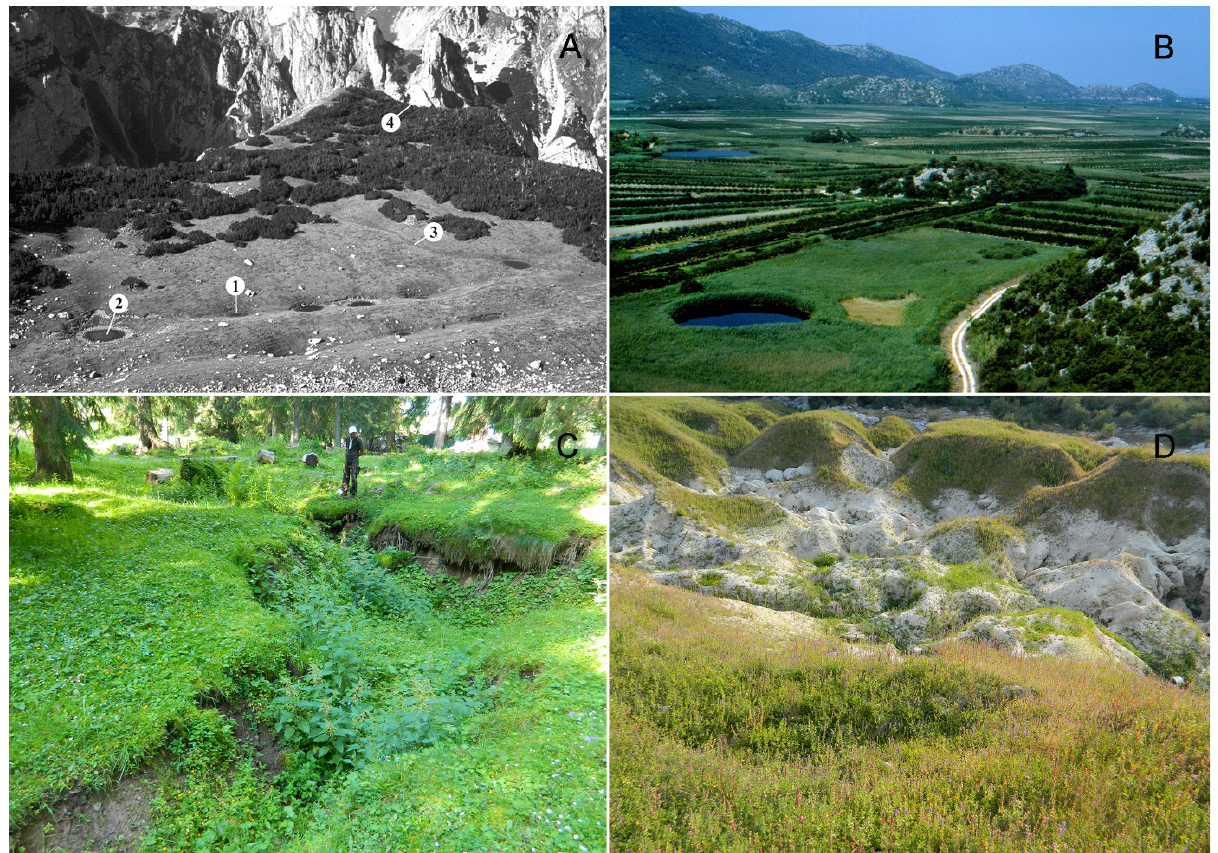
Figure 2. Subsidence dolines. ( A ) subsidence dolines that developed along fracture (Durmitor), 1. active doline, 2. inactive doline with lake, 3. path of water inflow, 4. Susica Canyon. ( B ) Dropout doline with lake in the Neretva river’s mouth (Croatia). ( C ) Subsidence doline that developed along fissure (Pádis, Romania). ( D ) subsidence dolines that developed in depressions of superficial deposit of a polje (Croatia).